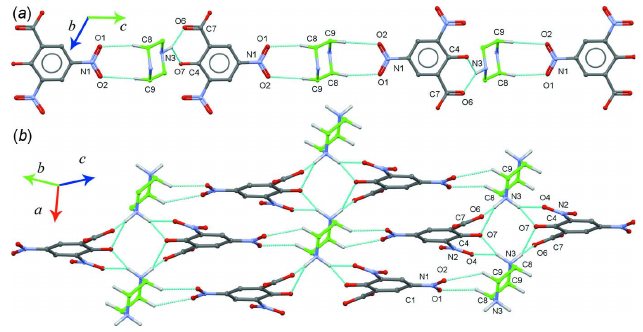
Figure 3 ( a ) Part of the crystal structure of (I) showing the R 2 formed by intermolecular N—H (cid:3)(cid:3)(cid:3) O and C—H (cid:3)(cid:3)(cid:3) O hydrogen bonds (see Table 1), which link the neighbouring anionic unit (DNSA 2 (cid:2) ) and cationic moiety (PIP 2+ ) into a molecular chain, which propagates parallel to the c axis. ( b ) Part of the crystal structure of (I) showing the sheet-like